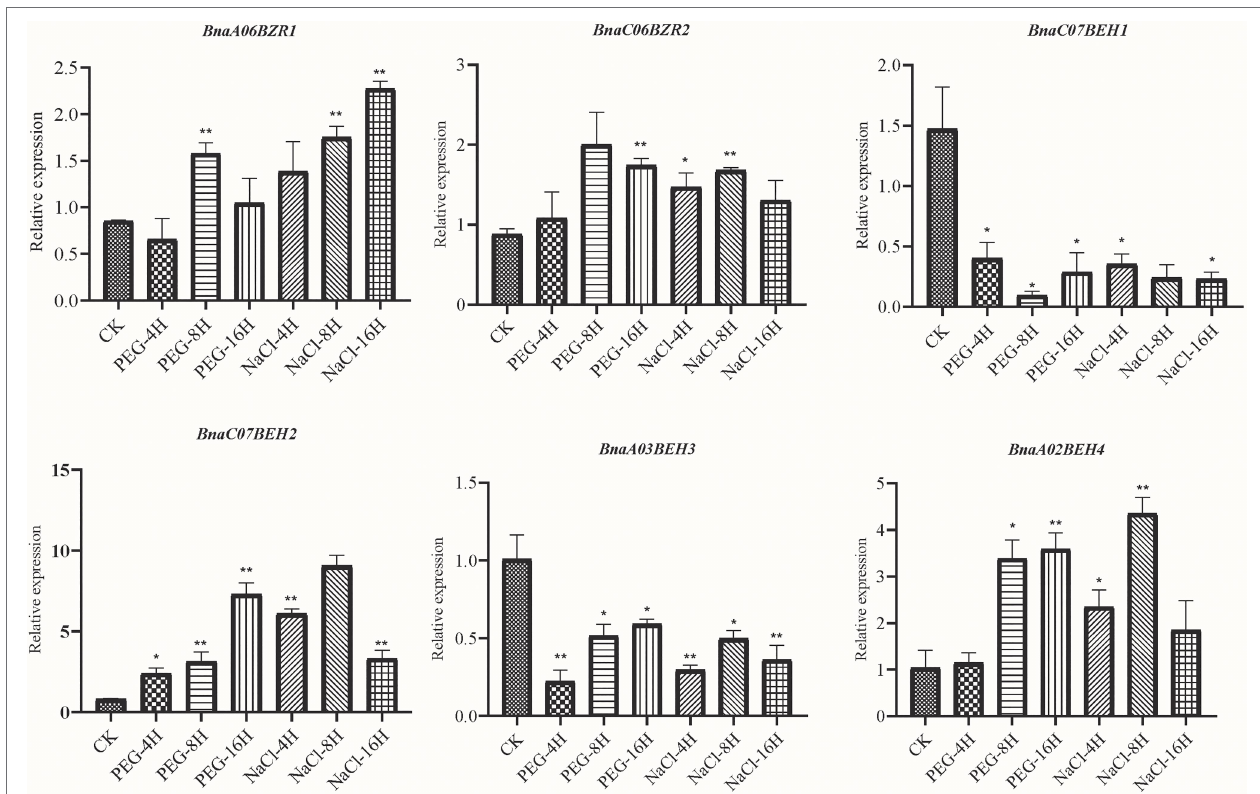
FIGURE 9 | The relative expression analysis of the BnaBZRs under different treatments. The expression abundance of the selected BnaBZRs was controlled with respect to the reference gene ( Actin ). The x -axis corresponds to different treatments, and values on the y -axis are denoted as the mean ± SE of three biological replicates (listed in Supplementary Table S9.2 ). Asterisk on vertical bar represent a significant difference at * p < 0.05 and ** p <